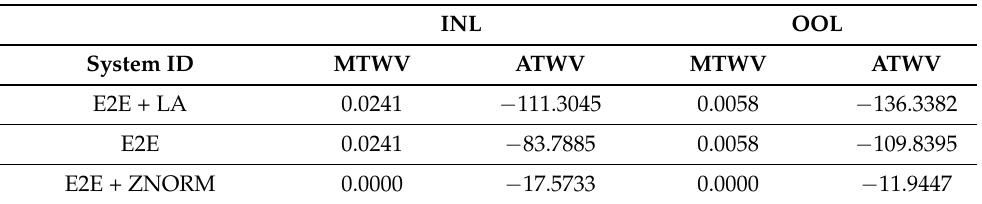
Table 24. System results of the QbE STD task for RTVE test data for in-language (INL) and out-of- language (OOL) queries.